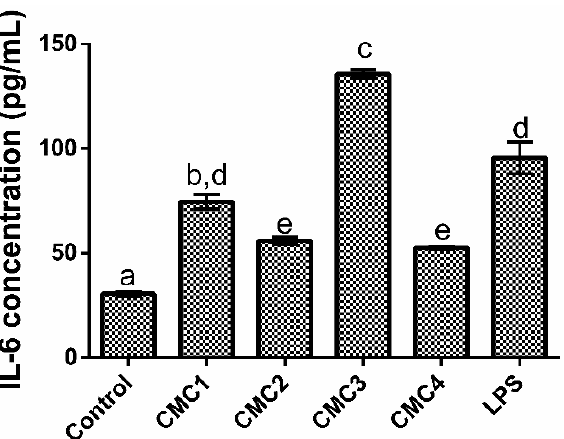
Figure 6. IL-6 production in HaCaT cells in the presence of CMC relative to the basal level (control). Different letters represent the statistically significant differences ( p < 0.05) found between conditions.